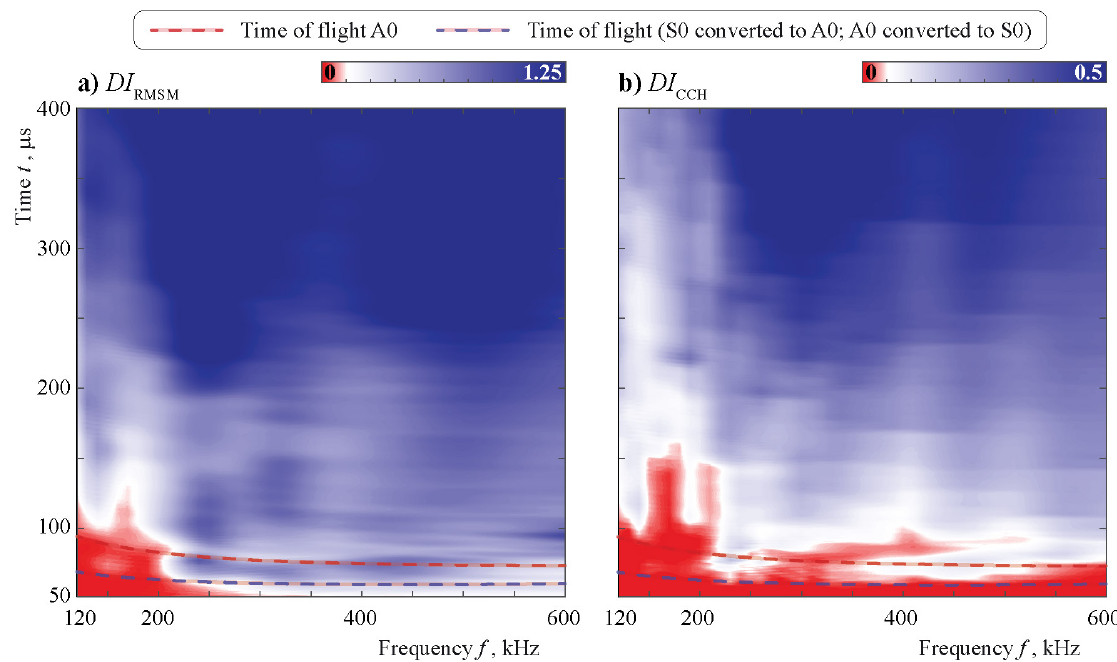
Figure 20. The DI DI m ( f , t ) calculated using the data from a sensor at different central frequencies f in the case of an obstacle with an imperfect contact stiffness κ = 2 × 10 13